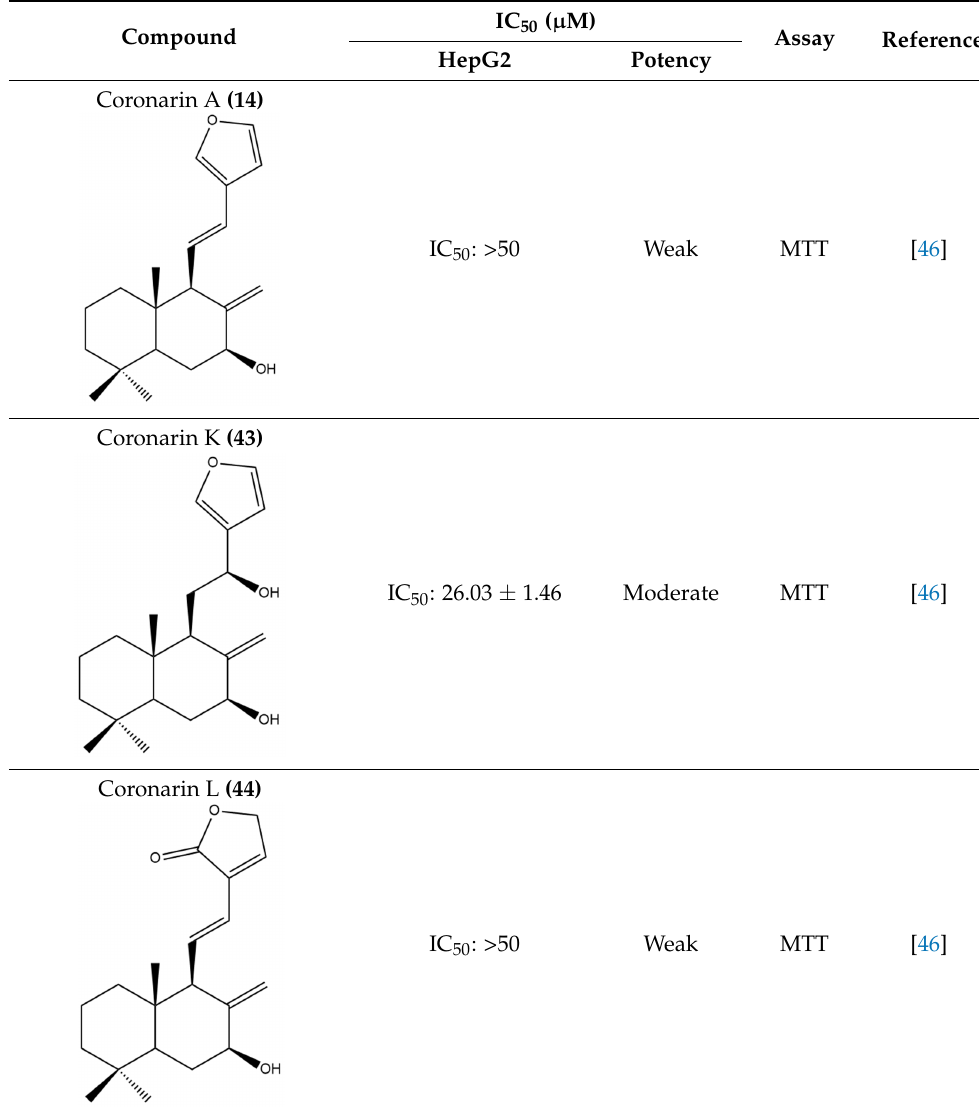
Table 14. Cytotoxic activities of labdane-type diterpenes from the Zingiberaceae against HT-29 colorectal cancer cell line.